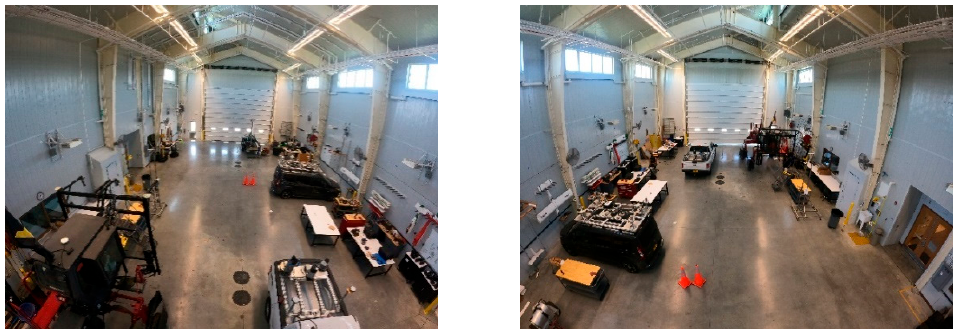
Figure 21. Sample images captured by the SMART system inside the site used for evaluating the inter-sensor mounting parameters.